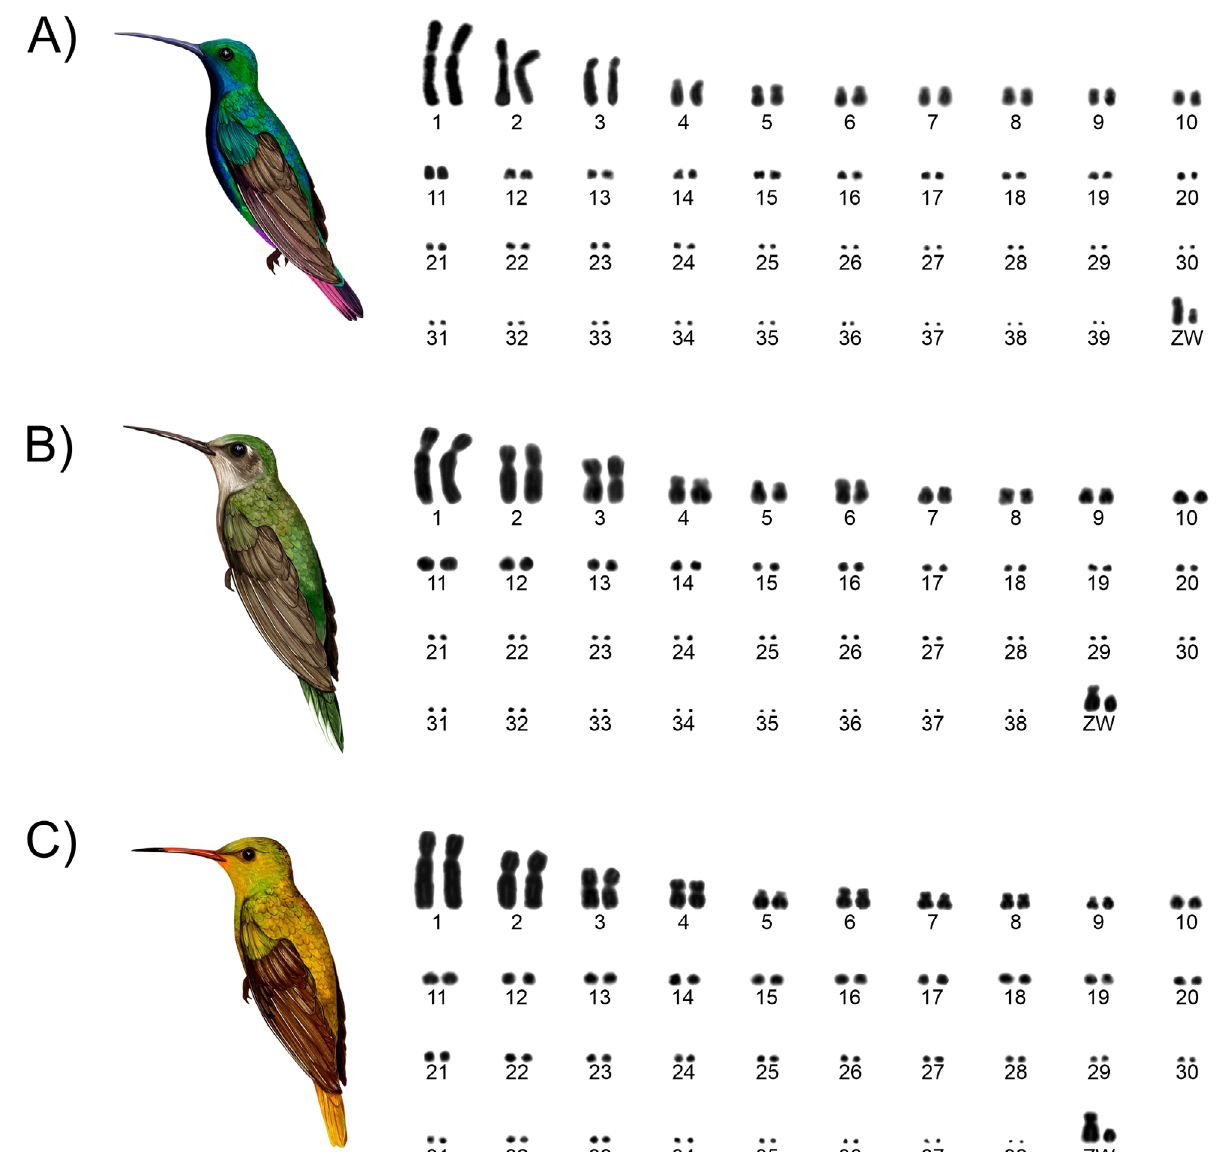
Figure 1 – Karyotypes of the three hummingbird species (family Trochilidae) analyzed in the present study. (A) Anthracothorax nigricollis 2n=80, (B) Campylopterus largipennis 2n=78, and (C) Hylocharis chrysura 2n=78.